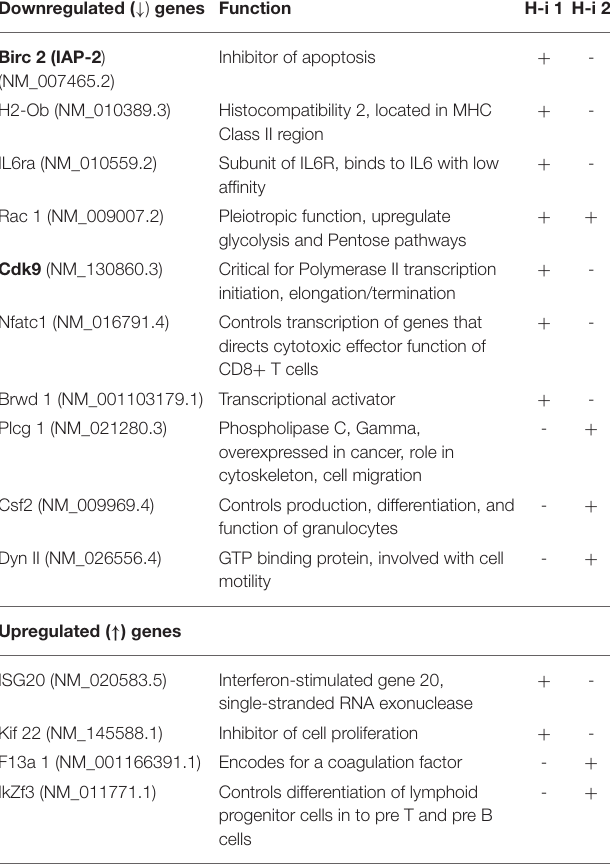
TABLE 1 | Significantly up-/down regulated selective genes relative to baseline in the Volcano plot of (H-i)-treated spleen 4 wks post 3 rd treatment, + , more prominently down- or up regulated; -, less prominent. Downregulated ( ↓ ) genes Function